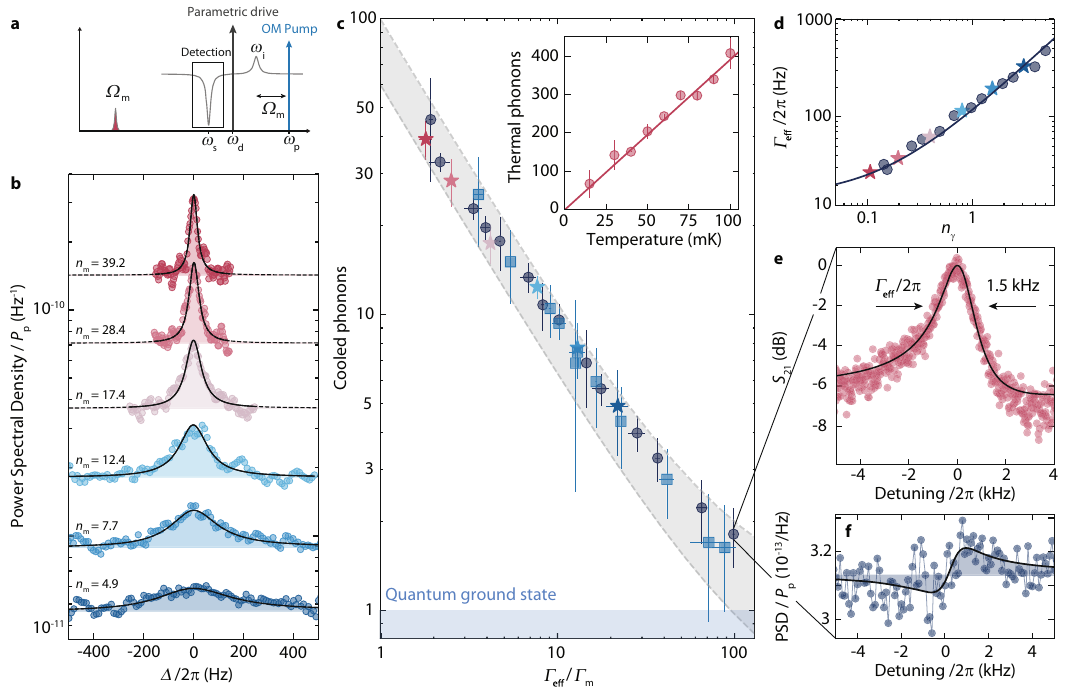
Fig. 4 Blue-detuned four-wave-cooling of a mechanical oscillator close to its quantum groundstate. a Schematic representation of the experiment. A parametric drive is used to activate the quasi-mode state and an optomechanical (OM) pump is sent to the blue sideband of the idler resonance ω ≈ ω + Ω p i m . The signal resonance output power spectral density is measured using a spectrum analyzer around b Power spectral densities normalized to the optomechanical pump input power P p for various pump powers. Frequency axis is given with respect to ω = ω + 2 Ω + Ω p dp m . With increasing pump power, the linewidth of the upconverted mechanical noise spectrum is increasing, indicating four-wave dynamical backaction damping. Simultaneously, the area of the normalized signal decreases, indicating cooling of the mode. From fi ts (lines and shaded areas) to the data (points), we determine the resulting phonon occupation n m . In c , we show the cooled phonon number vs Γ eff / Γ m in a collection of sever`al different datasets. Intracavity drive photon numbers vary between different points in the range 30 < n d < 110. Circles correspond to data from measurements at operation point I and squares to data from operation point II. Stars show the points that correspond to the data shown in b , taken at operation point I. All measurements have been taken at B ∥ = 25 mT. The inset shows the result of a thermal calibration measurement, indicating that the mechanical oscillator mode equilibrates with the fridge base temperature and the residual thermal occupation at T b = 15 mK is n th and shaded area display the theoretically calculated range of four-wave-cooled phonon occupation, taking into account a possible range of 60 (cid:9) n th and 45 ≤ n d ≤ 90. Parametric ampli fi cation of cavity quantum noise limits the minimally achievable phonon occupation in our parameter regime to (cid:6) 0 : 6. For the highest powers, we exceed this theoretical limit by only a factor ~3. d shows the effective effective mechanical linewidth vs intracavity n lim m sideband photon number n γ = ∣ γ − ∣ 2 + ∣ γ + ∣ 2 for points from c , which have nearly constant n d ≈ 87 ± 11, demonstrating that we achieve signi fi cant cooling with a small number of photons. The line corresponds to theory with Γ m = 2 π ⋅ 15 Hz. e shows an OMIT scan at the point of largest cooling Γ eff with an effective linewidth Γ eff ≈ 2 π ⋅ 1.5 kHz, which corresponds to an effective four-wave cooperativity of C fw ≳ 100. f shows the corresponding power-spectral density in units of quanta, displaying an asymmetric-noise lineshape due to a small, but fi nite effective temperature of the cavity by ampli fi ed quantum noise. Error bars in c consider uncertainties in the fi tting procedure and in the bare mechanical linewidth, for details see Supplementary